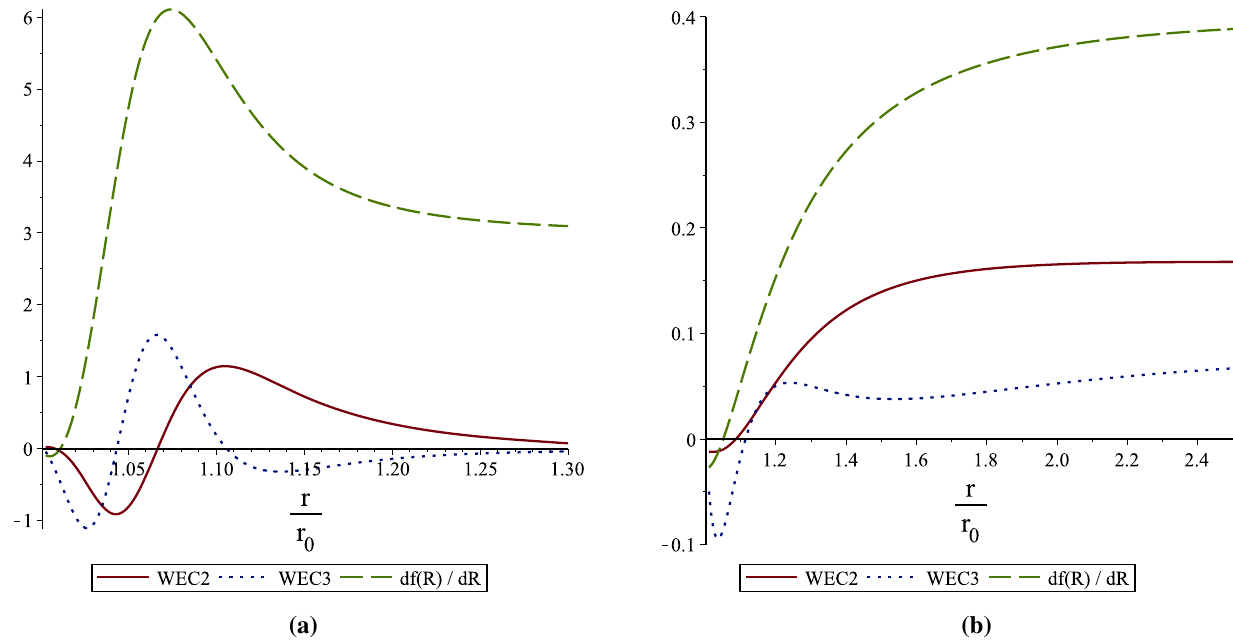
Fig. 10 In the case of Starobinsky model, a , b show F , WEC2,3 for the asymptotically hyperbolic and spherical wormhole solutions respectively. In both cases by fixing λ = 1 , R ∗ = 1 the F < 0 is satisfied around r 0 , however the NEC are violated. We set r 0 = 0 . 55 , n = 2 . 25 in a and